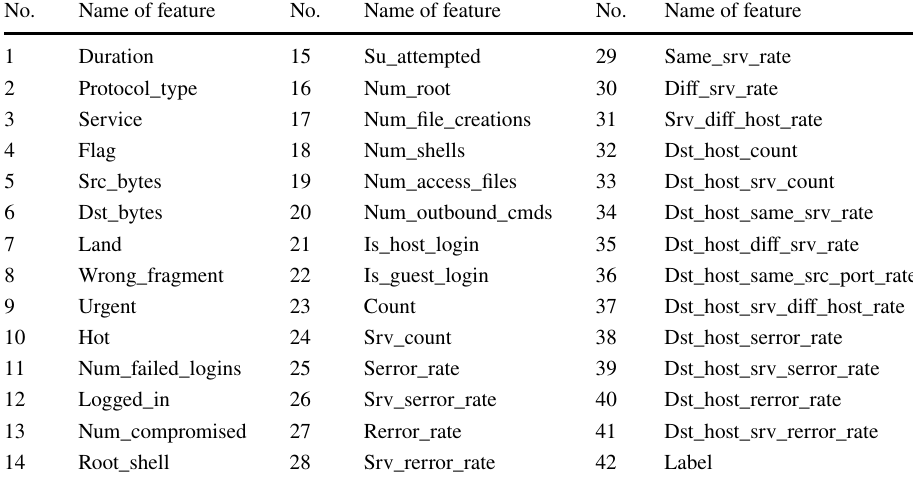
Table 5 List of features